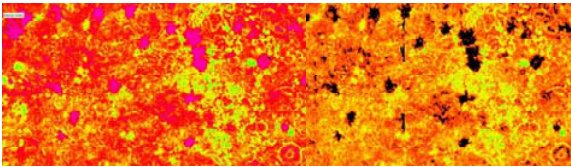
Figure 6 Intensity values for the fruticose lichen on stone 29 (pink areas) digitally removed from the scan (black